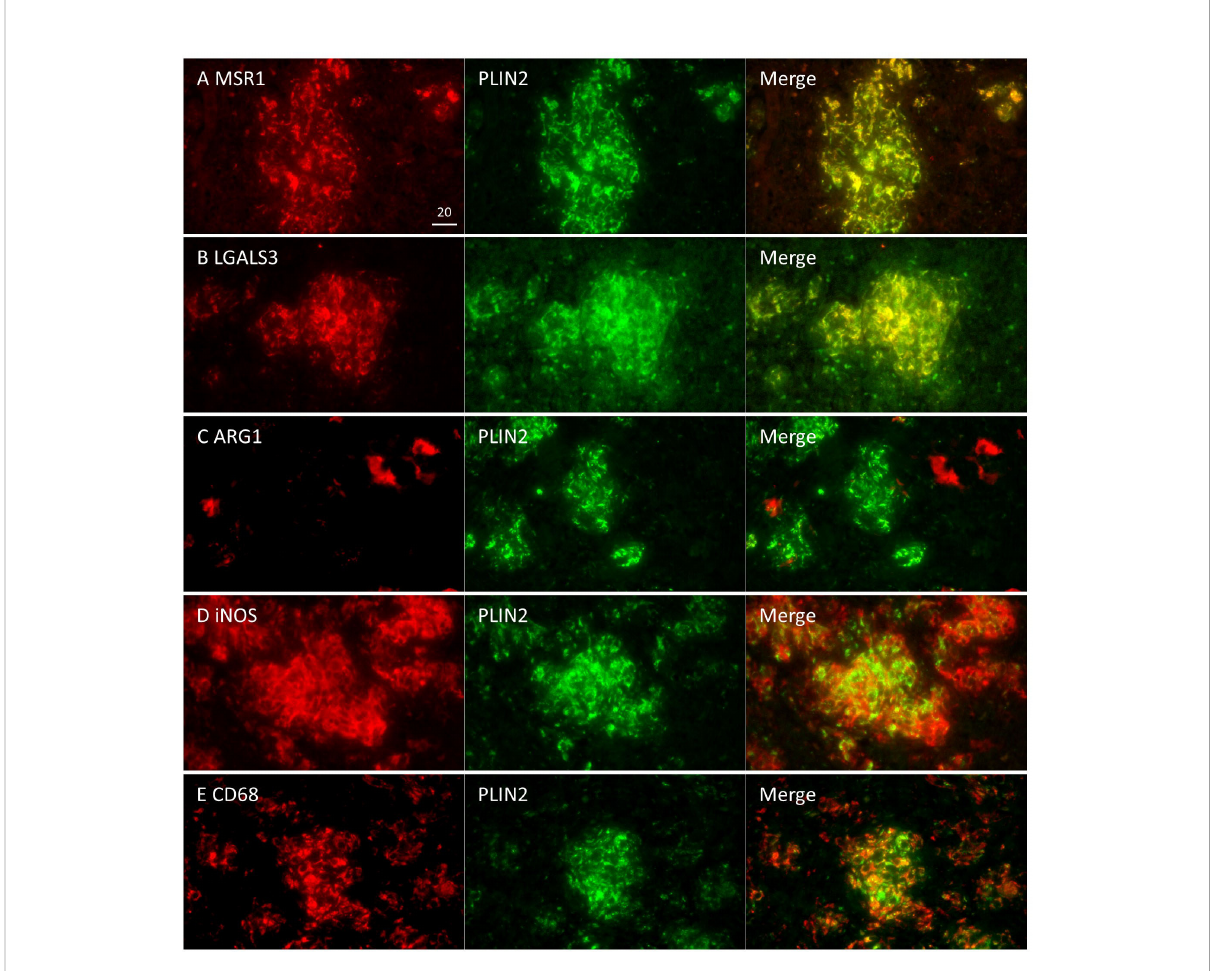
FIGURE 6 Localization of FM markers and macrophage activation markers in non-necrotic granulomas. Localization of MSR1 (A) , LGALS3 (B) , iNOS (C) , CD68 (D) , and ARG1 (E) to PLIN2 + cells was examined in non-necrotic granulomas at 8 weeks